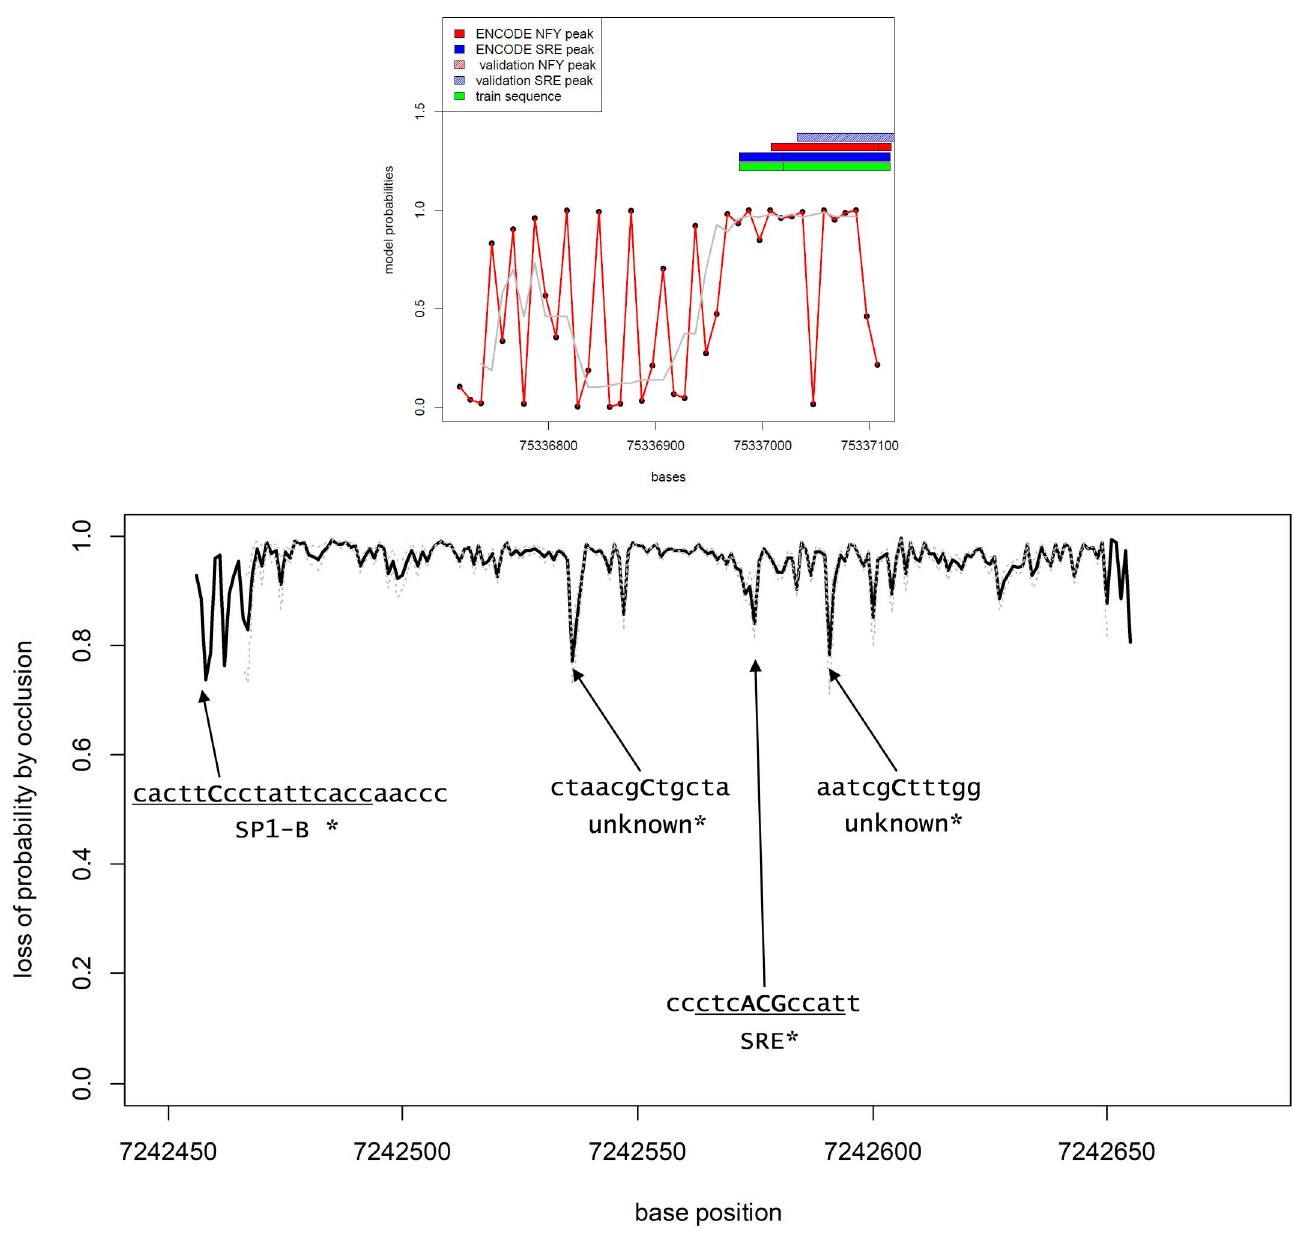
Fig 3. Evaluation of the HMGCR promoter by the CNN 1-D